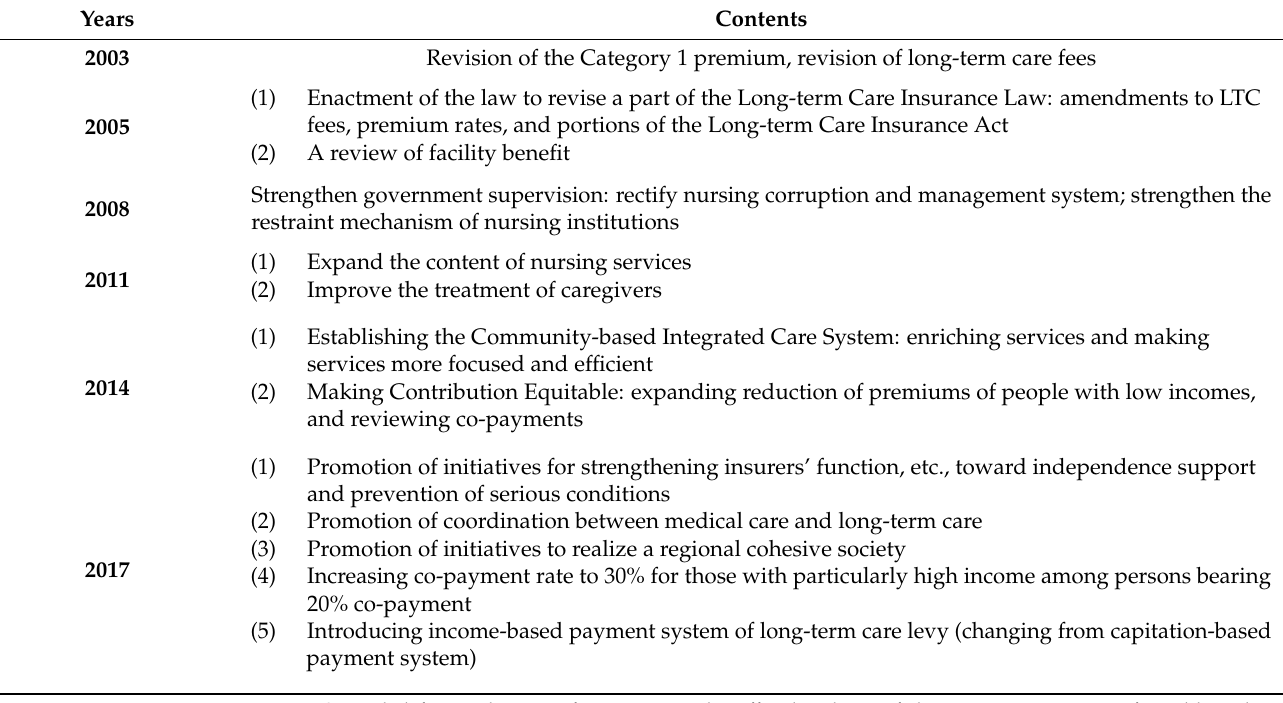
Table 2. The reforms of Japan’s long-term care insurance